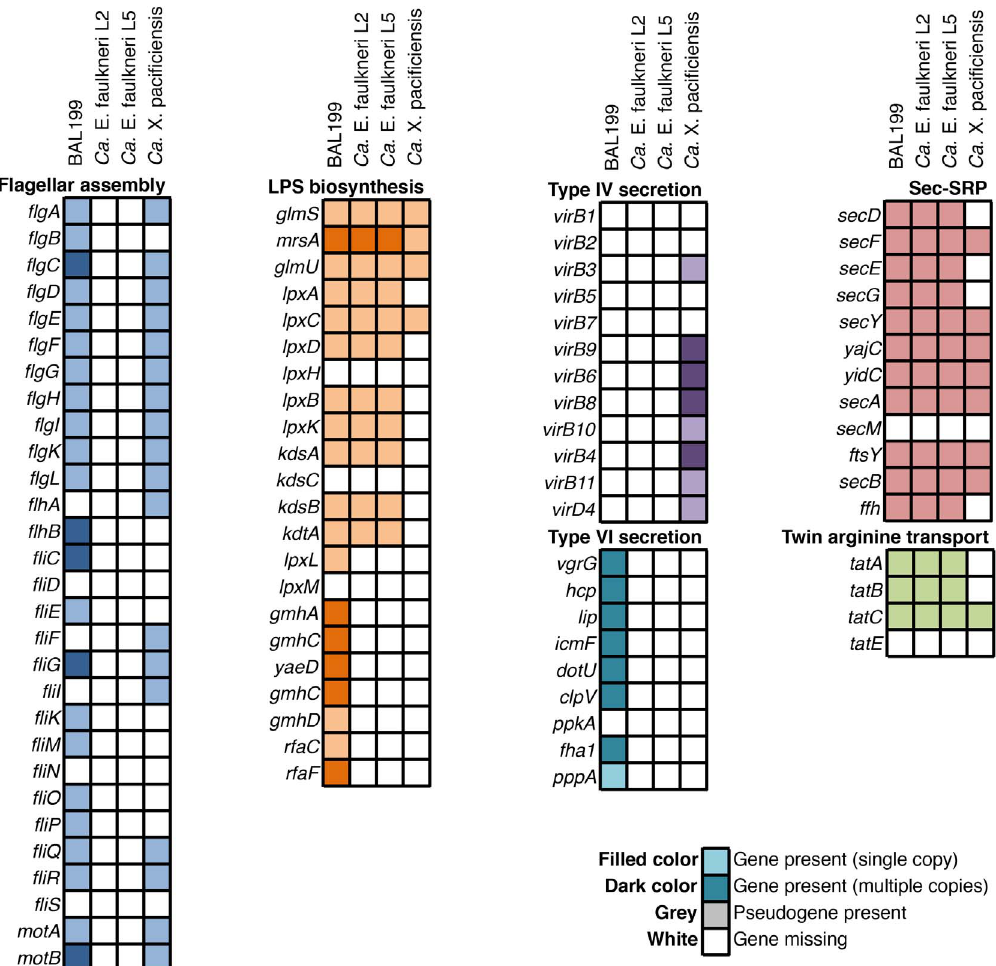
Figure 14. Ca. X. pacificiensis possesses genes involved in various pathogenicity-related processes, while Ca. E. faulkneri lacks genes in these categories.